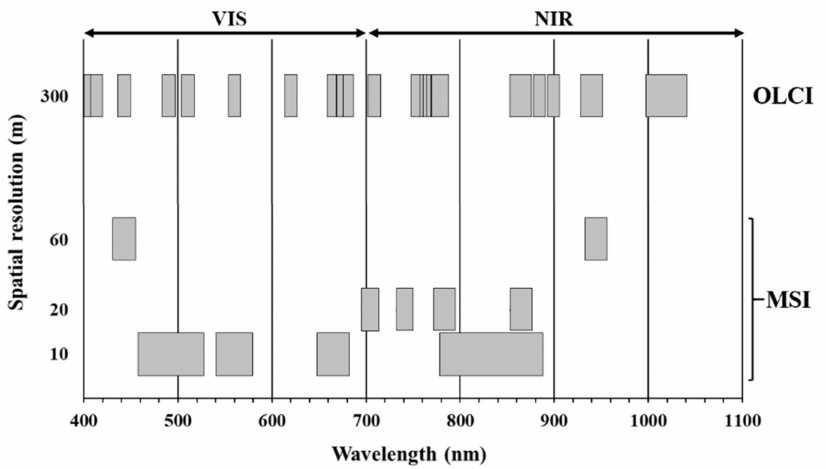
Figure 1. Spectral bands and spatial resolution of MultiSpectral Instrument (MSI) and Ocean and Land Color Instrument (OLCI)